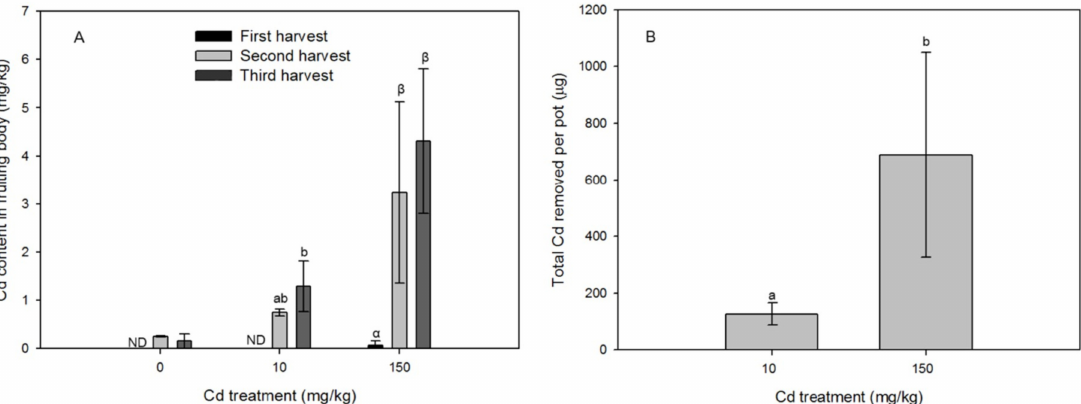
Figure 3. Dynamics in fruiting body Cd content in the two Cd treatments and the control over the 35-day cultivation ( A ), and the total Cd removal per pot calculated based on the Cd content of fruiting body and substratum ( B ). Bars with different letters are significantly different at p ≤ 0.05 (One-Way ANNOVA). ND, not